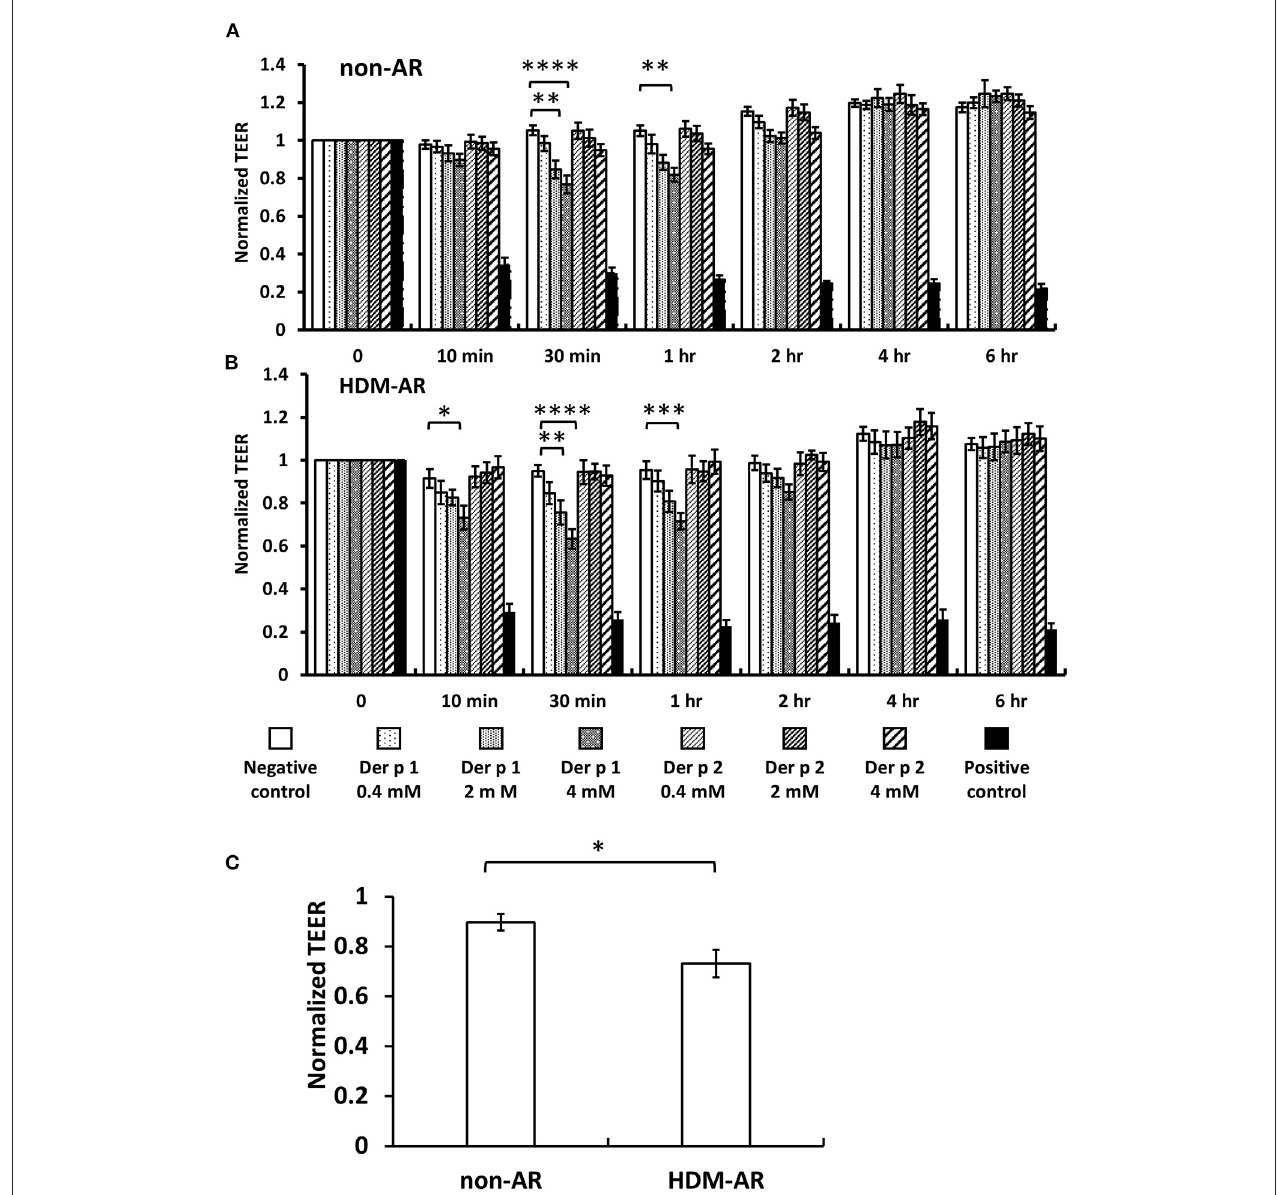
FIGURE 1 | Der p 1 reduced TEER of HNEC-ALI cultures transiently in a dose dependent manner. TEER was measured at time point = 0 (immediately after application of test compound), 10, 30min, 1h and hourly for 6h after application of PBS (negative control), 0.4, 2, and 4mM Derp1 or Derp2 or 5% Triton (positive control) to HNEC-ALI cultures from non-AR patients (A) or HDM-AR patients (B) . Values were normalized to the values at time point = 0 and compared to negative control at the same time point. * p < 0.05, ** p < 0.01, *** p < 0.001, **** p < 0.0001, one-way ANOVA followed by Dunnett’s test. (C) TEER reduction by 4mM Der p 1 challenge for 10min was compared between non-AR group and HDM-AR group. * p < 0.05, Student t test. HDM, house dust mite; AR, allergic rhinitis All data are shown as the means ± SEM. ( n = 9; respectively for each group).